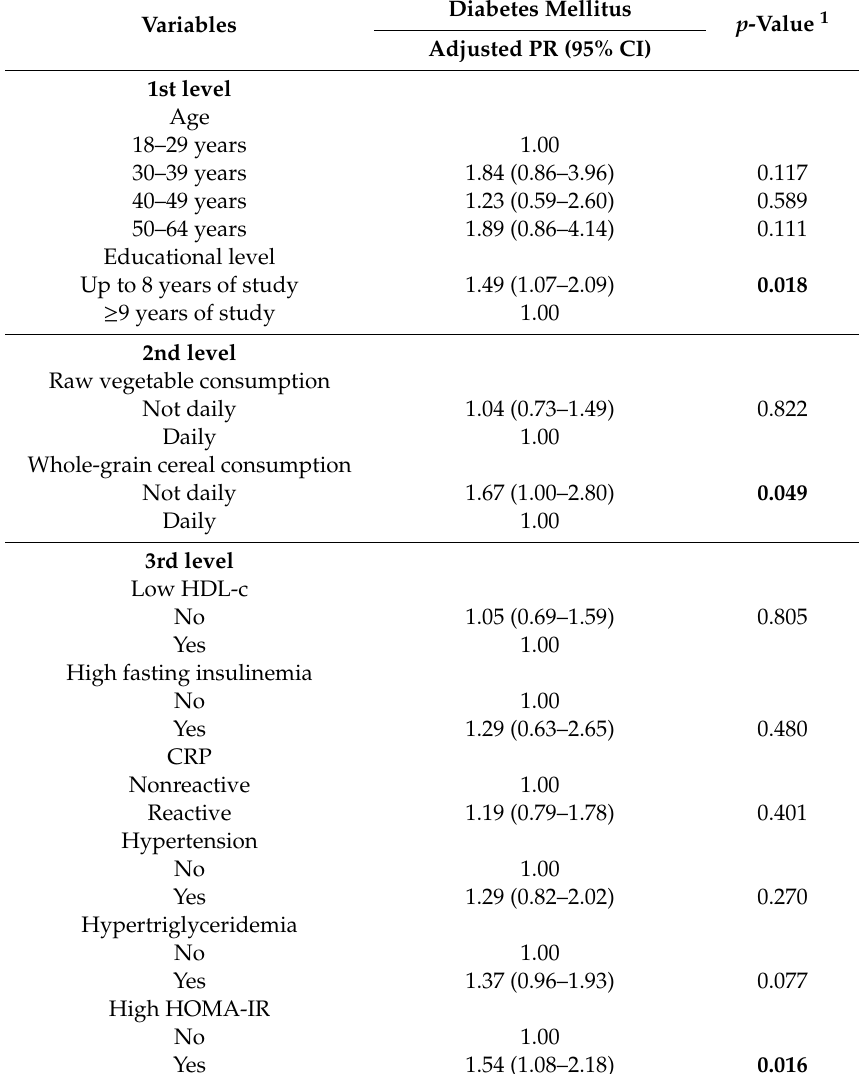
Table 3. Variables associated with type 2 diabetes mellitus in class II and III obese individuals after hierarchical multivariate analysis and adjustment for hypoglycemic agent